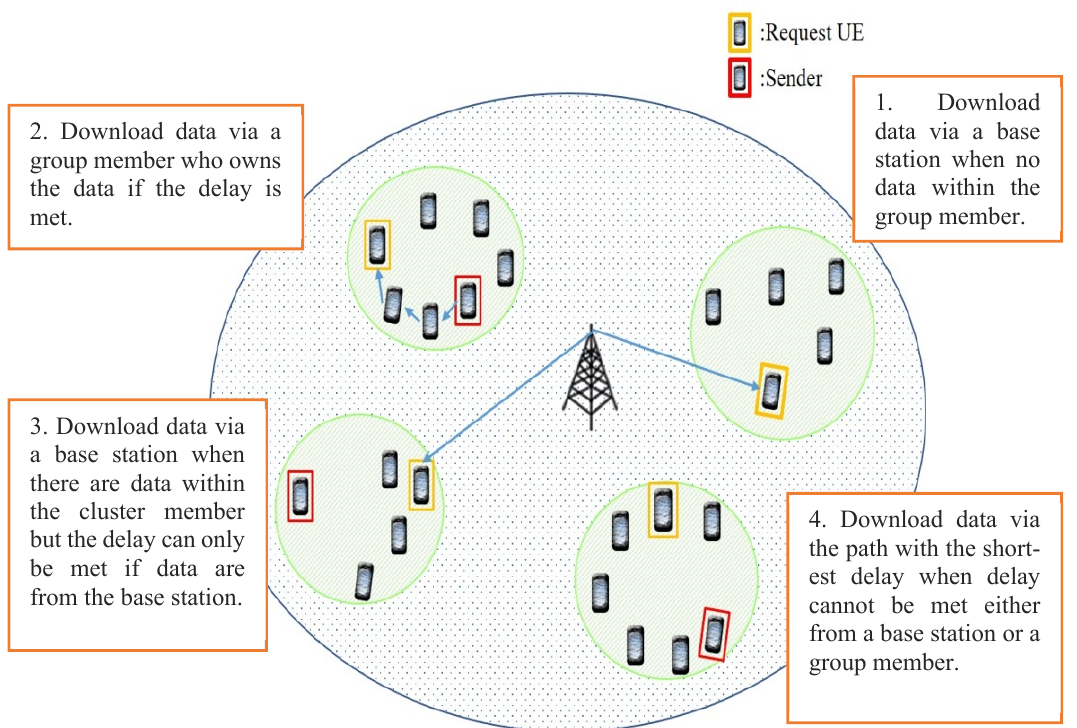
Figure 3. An illustration of the intended environment.